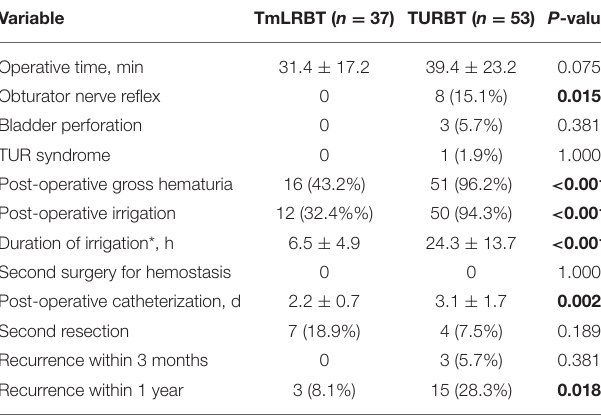
TABLE 2 | Intraoperative, postoperative and oncological outcomes. Variable